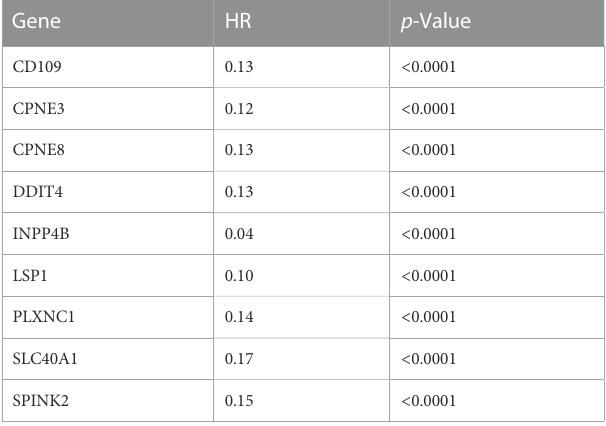
TABLE 4 The estimated hazard ratio of each prognostic gene included in the Cox regression for the independent test dataset